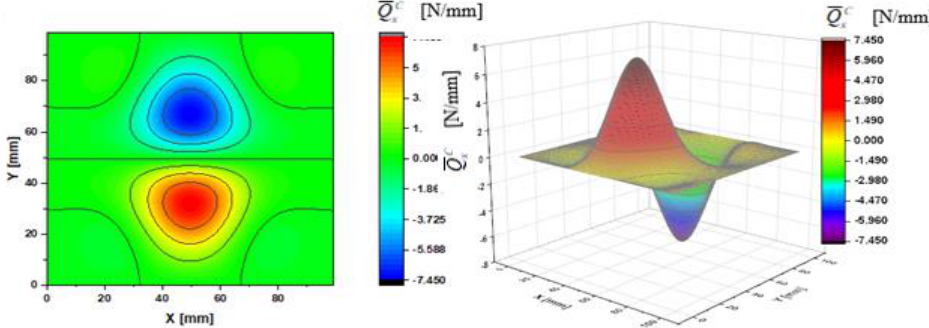
Figure 4. Contour-plane chart of C